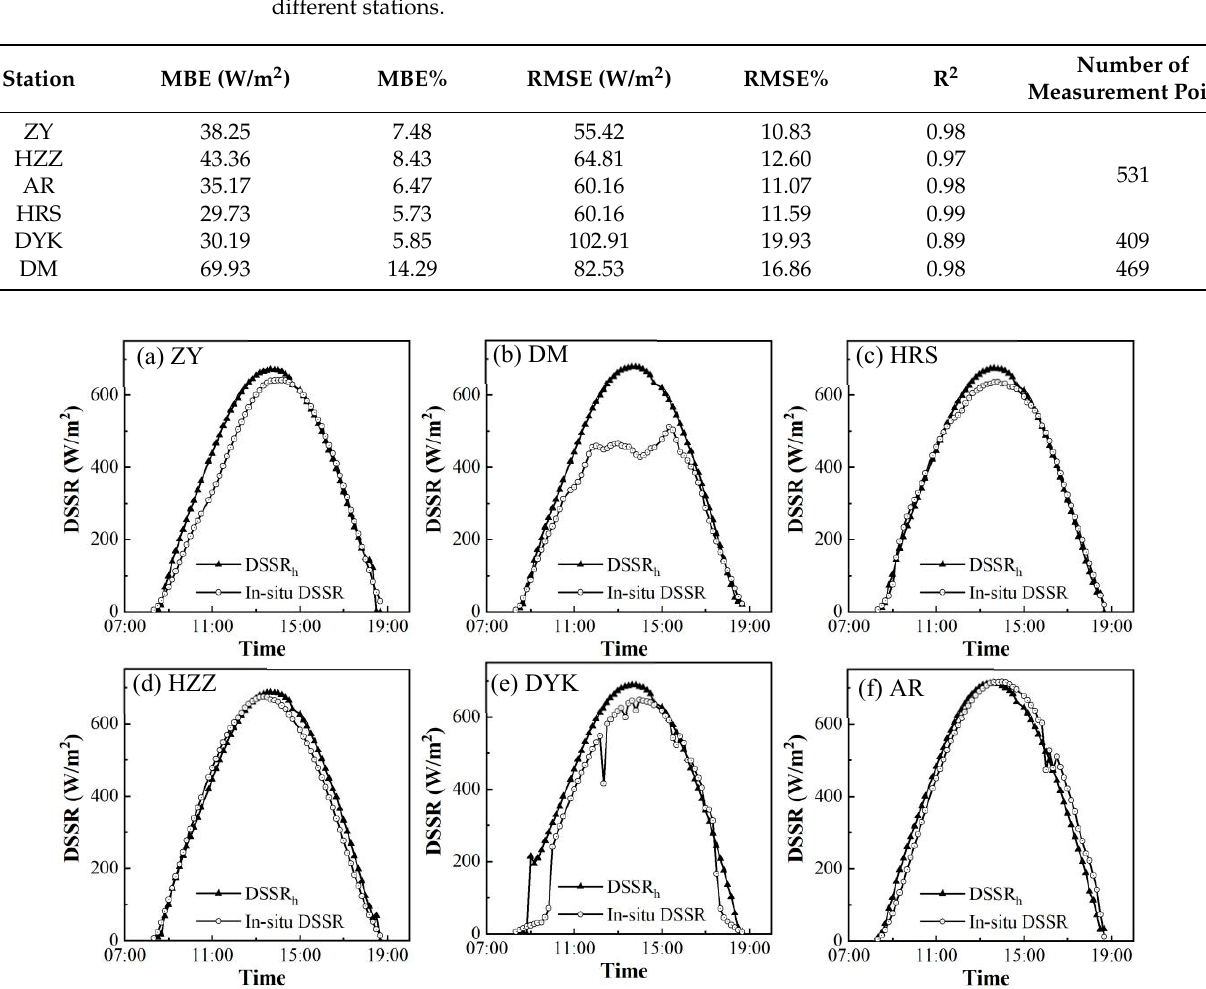
Figure 12. The diurnal cycle of DSSR from downscaled H8 and ground observations after cosine correction at six sites on 15 February 2019: ( a ) ZY; ( b ) DM; ( c ) HRS; ( d ) HZZ; ( e ) DYK; ( f )